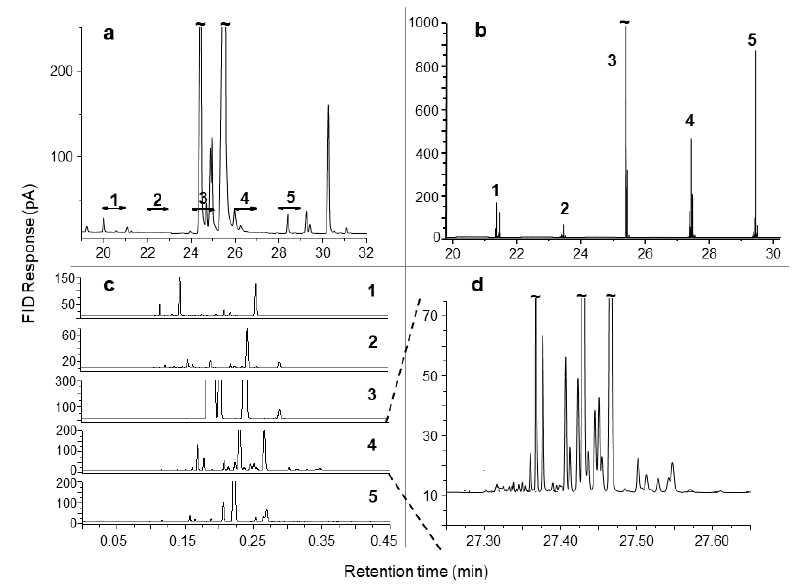
Figure 6. Peppermint essential oil chromatograms, showing: ( a ) the 1 D GC-FID result indicating the regions 1–5 to be heart-cut; ( b ) the 2 D GC-FID results of the analysis of all the five heart-cuts with cryofocussing; ( c ) the expanded separation window, comparing the separation of all five selected regions, with retention times given from the introduction of each region to the 2 D column; and ( d ) the expanded result of heart-cut 4, showing a total retention time of about 24 s. Source: adapted with permission from Dunn et al. [116].